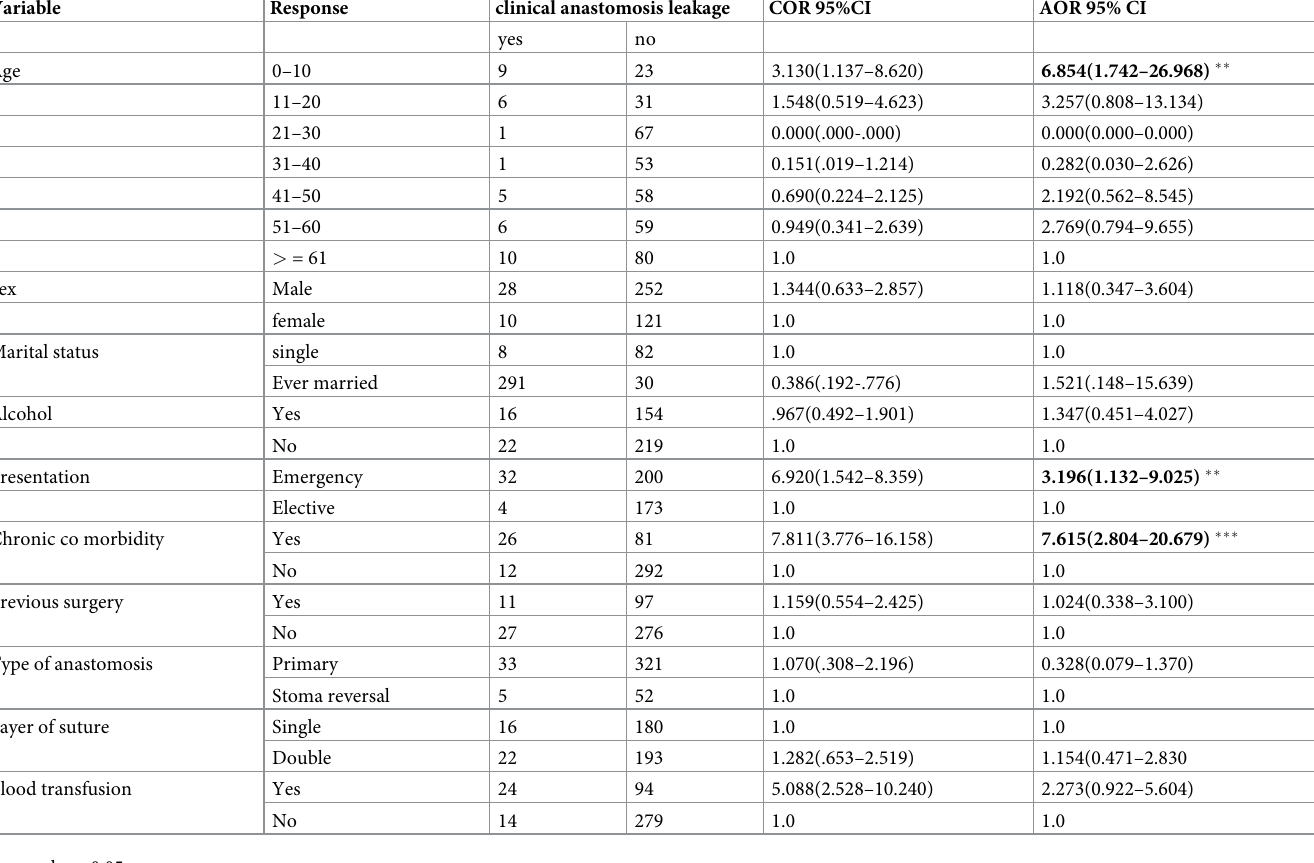
Table 5. Multivariable logistic regression of factors associated with clinical anastomosis leakage among patients who had intestinal anastomosis in Northwest Amhara regional State referral Hospitals, from February 2017 to February 2020 (n = 411).